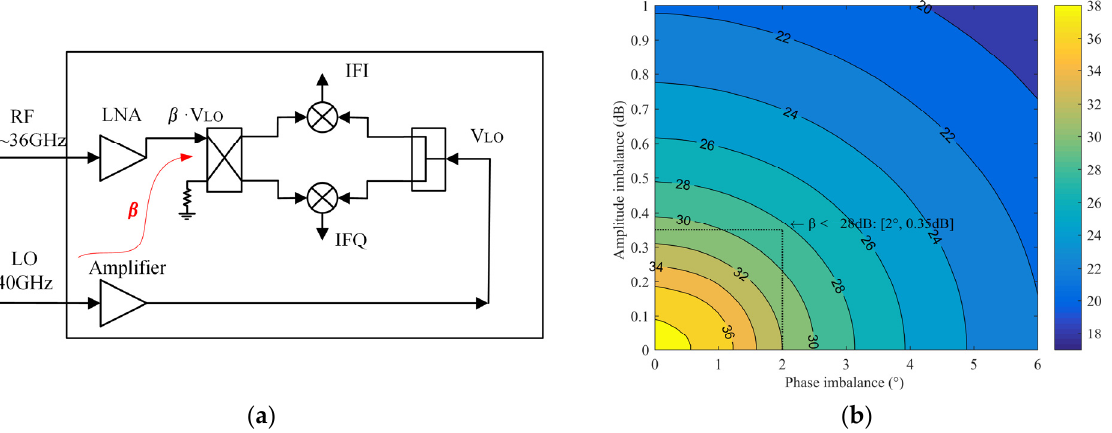
Figure 6. ( a ) Analysis of the influence of coupling 𝛽 on the imbalance; ( b ) Amplitude and phase imbalance caused by the coupling 𝛽 .